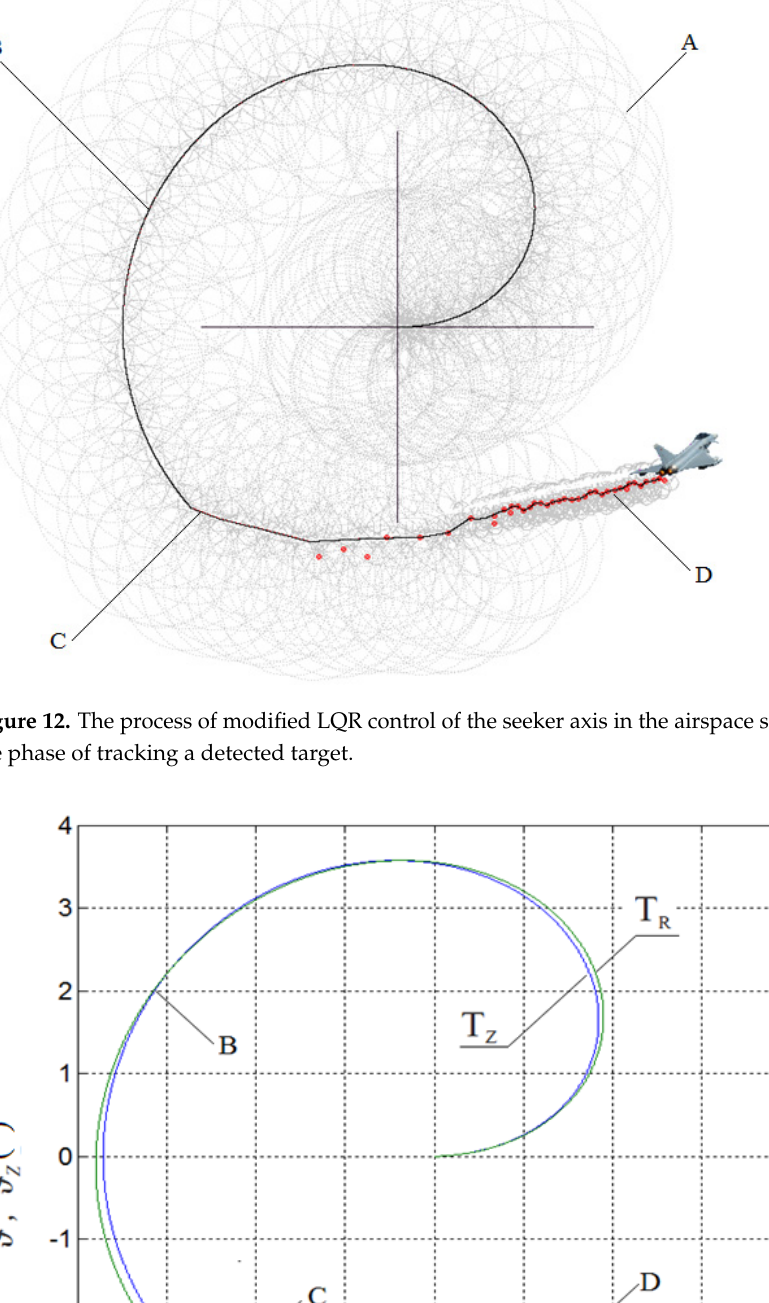
Figure 14. T Z set trajectory and pursued T R trajectory of the seeker axis in the airspace search phase and in the detected target tracking phase–modifiedLQR control.